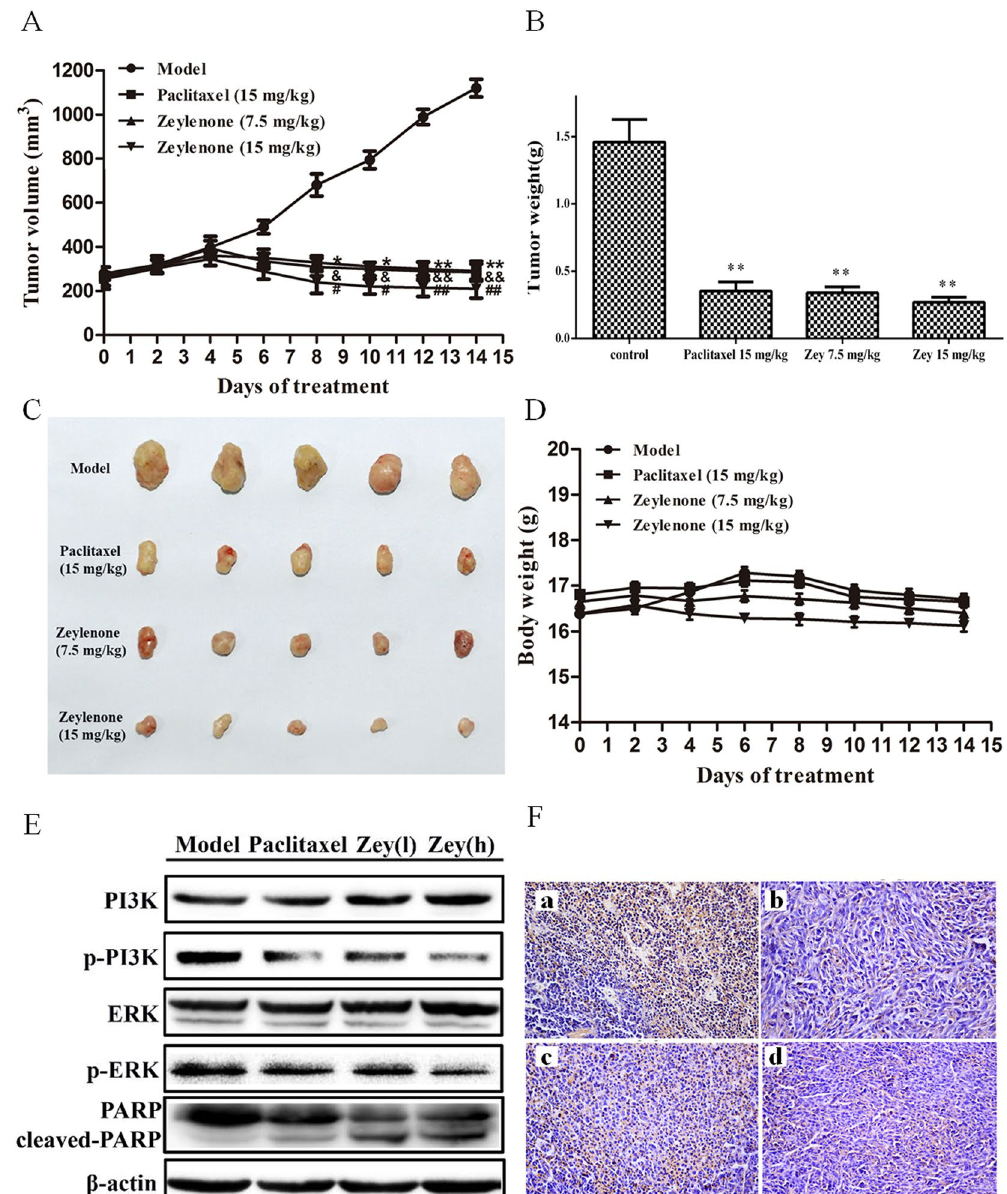
Figure 8. Zey inhibits tumor growth, induces clevage of PARP, and reduces expression of p-PI3K and p-ERK in nude BALB/c mice bearing HeLa xenograft. HeLa cells were transplanted subcutaneously to the BALB/c nude mice and subjected to Zey (7.5 and 15 mg/kg), paclitaxel (15 mg/kg) and saline (as the negative control) for 14 days. ( A ) Tumor volume of each group. ( B ) Tumor weight of each group. On day 14 after inoculation, the mice were sacrificed, and the tumor tissues were isolated, weighed, and summarized. Mean ± SD (n = 5). ** P < 0.01, versus model group. ( C ) Photographs of tumors in each group. ( D ) Body weight were mesured every 2 days. ( E ) Immunoblot analyses of PI3K, p-PI3K, ERK, p-ERK, PARP, and cleaved-PARP in tumor tissues ( F ) Immunohistochemical analysis of p-PI3K in tumor tissues. (a) Mice treated with vehicles, (b) mice treated with Paclitaxel (15 mg/kg), (c) mice treated with Zeylenone (7.5 mg/kg), (d) mice treated with Zeylenone (15